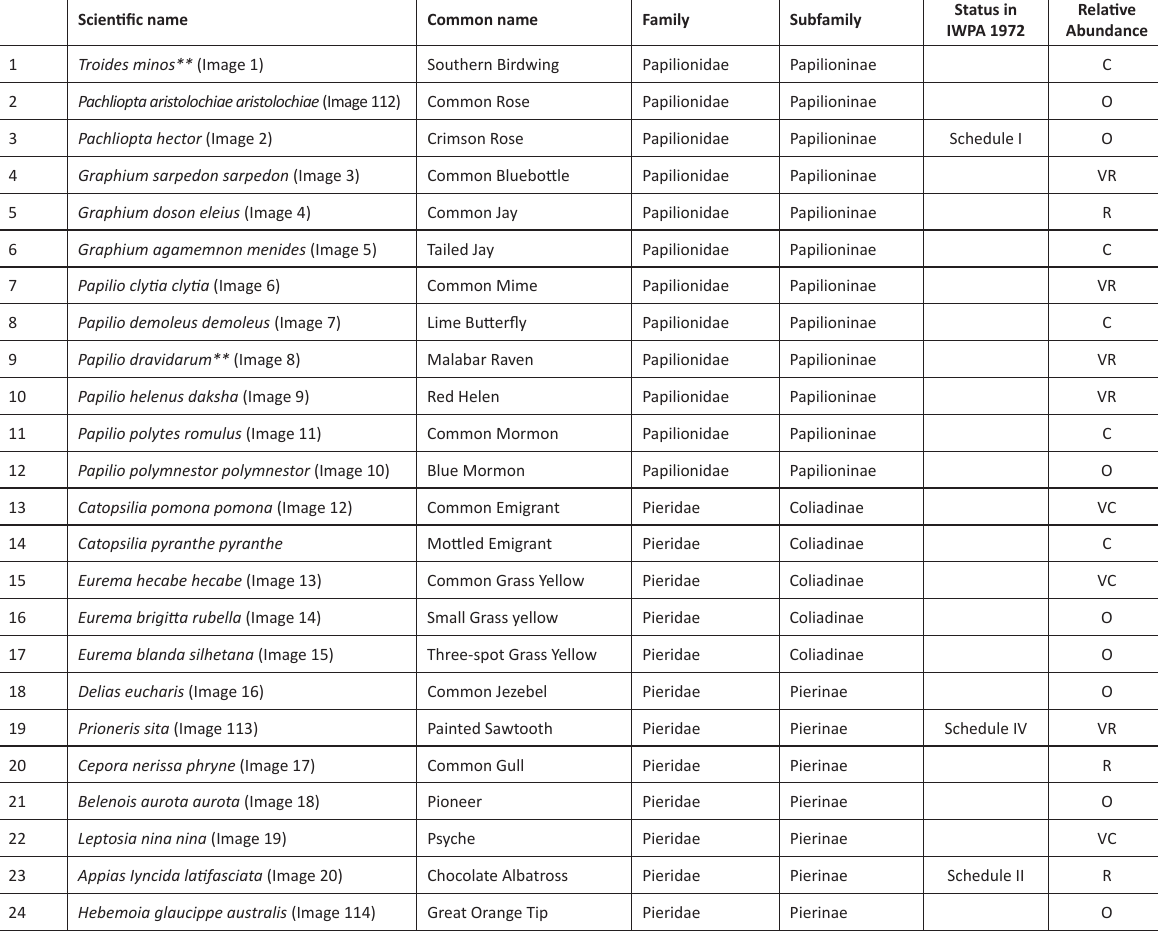
Table 1. Checklist of butterflies of Kerala Agricultural University campus, Thrissur, Kerala